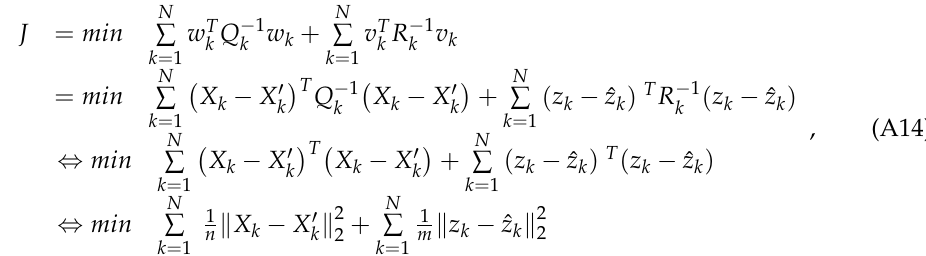
Figure A1. Description of ( ) So, our regression problem z ∗ where we aim to minimize the measurement error w k = X k − h ( z k ) = X k − X (cid:48) k and